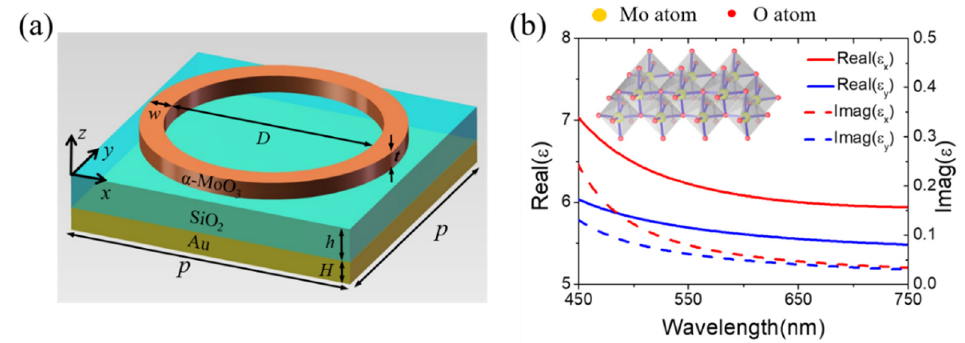
Figure 1. ( a ) The structure unit cell diagram of the proposed absorber consisting of top α -MoO 3 ring and SiO 2 layer stacked on a gold substrate. In this design, the geometrical parameters are listed as follows: H = 200 nm, h = 300 nm, w = 40 nm, D = 360 nm, p = 500 nm, and the thickness of α -MoO 3 ring t = 105 nm. ( b ) The real part and imaginary part of the α -MoO 3 permittivity in the visible region. The inset is the schematic of the α -MoO 3 material with layered structure. The yellow and red spheres represent molybdenum and oxygen atoms, respectively. Table 1. Parameters used in Equation (1) to obtain the permittivity tensors of α -MoO 3 in the visible range. Polarization ε